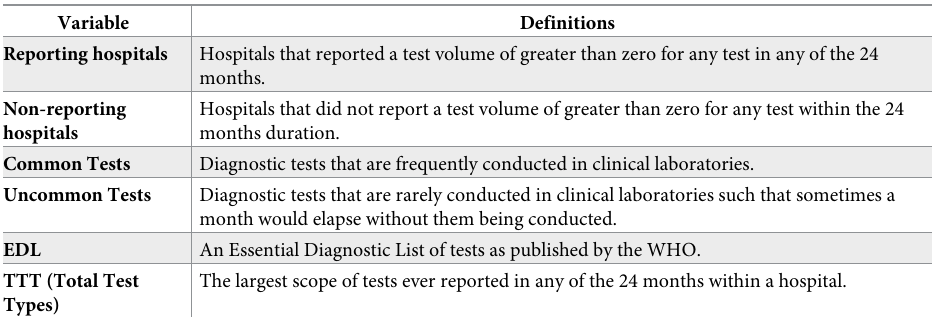
Table 2. Showing variable